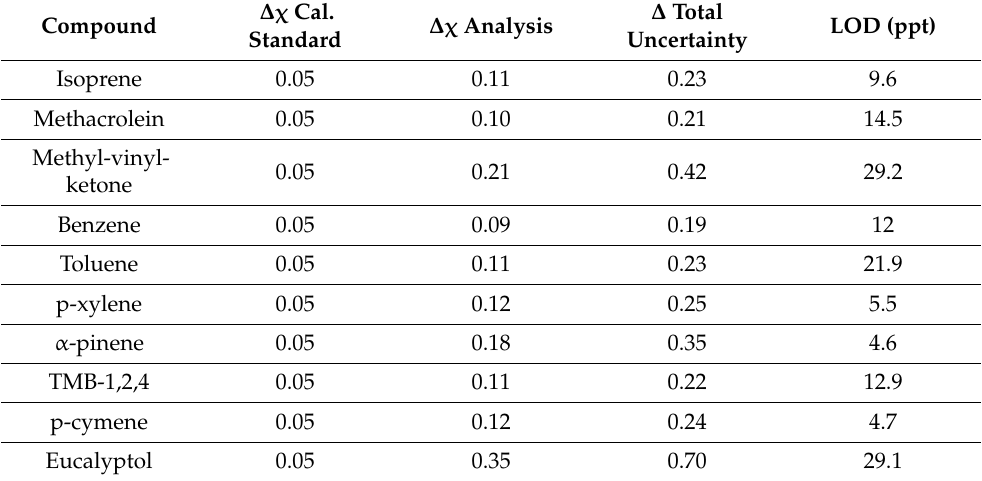
Table 3. Estimated LOD and relative uncertainty for hourly measurements of each VOC using the BAASS system during the sampling period. ∆ χ Cal. ∆ χ Compound